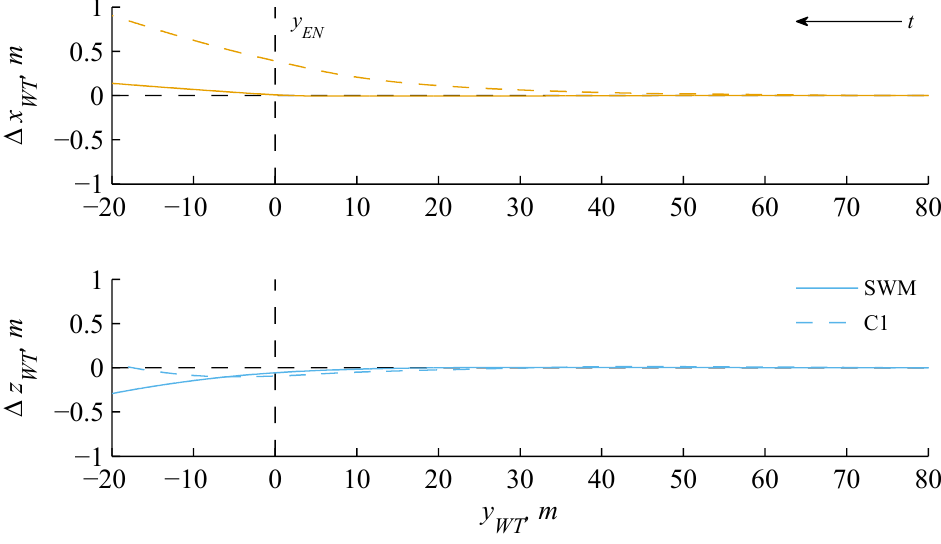
Figure 16. Lateral and vertical flight path deviations ( ∆ x non-piloted , ∆ z non-piloted ) of the non-piloted simulation from the ideally straight line for C1 and SWM at position